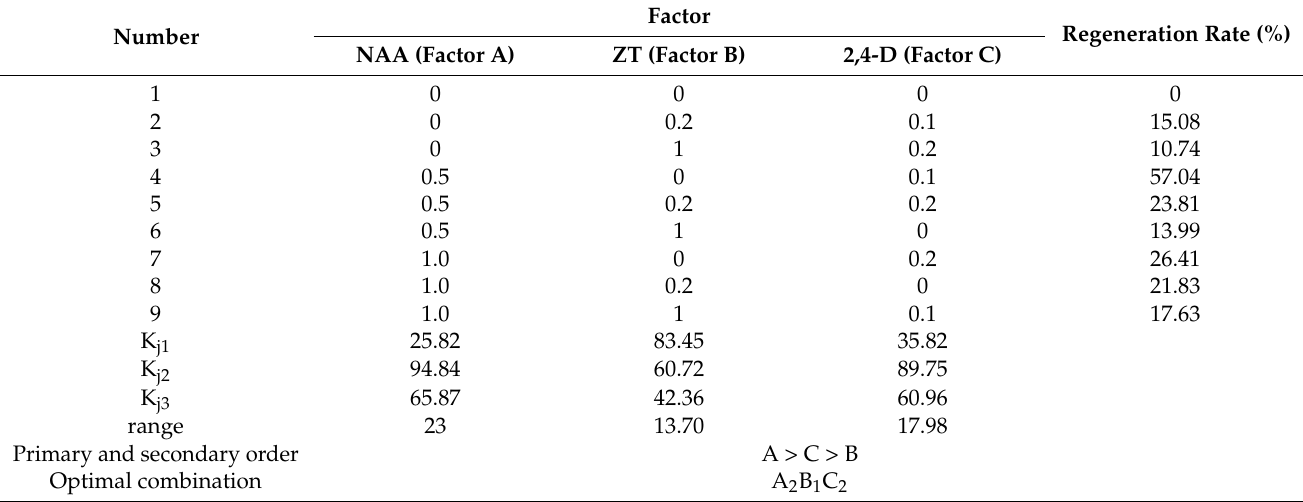
Table 2. Modification of medium used to induction culture H. serrata